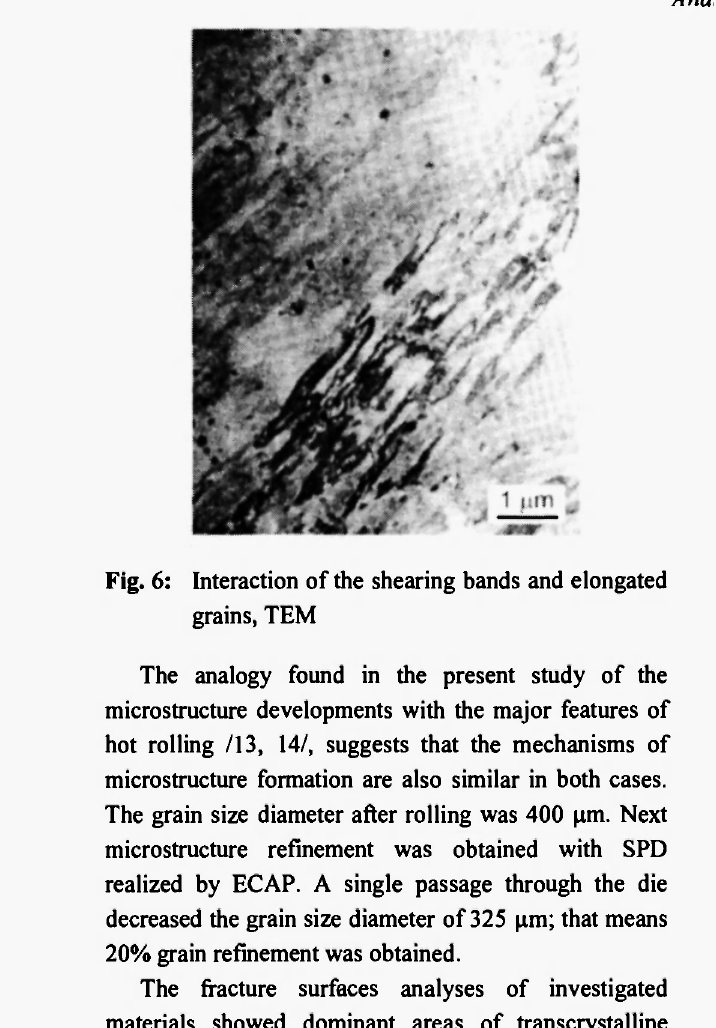
Fig. 6: Interaction of the shearing bands and elongated grains, TEM The analogy found in the present study of the microstructure developments with the major features of hot rolling /13, 14/, suggests that the mechanisms of microstructure formation are also similar in both cases. The grain size diameter after rolling was 400 μηι. Next microstructure refinement was obtained with SPD realized by ECAP. A single passage through the die decreased the grain size diameter of 325 μπι; that means 20% grain refinement was obtained. The fracture surfaces analyses of investigated materials showed dominant areas of transcrystalline ductile fracture /15/, Fig. 7.